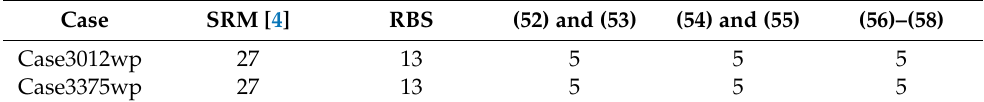
Table 2. Total iterations of various continuous methods for ill-conditioned cases.